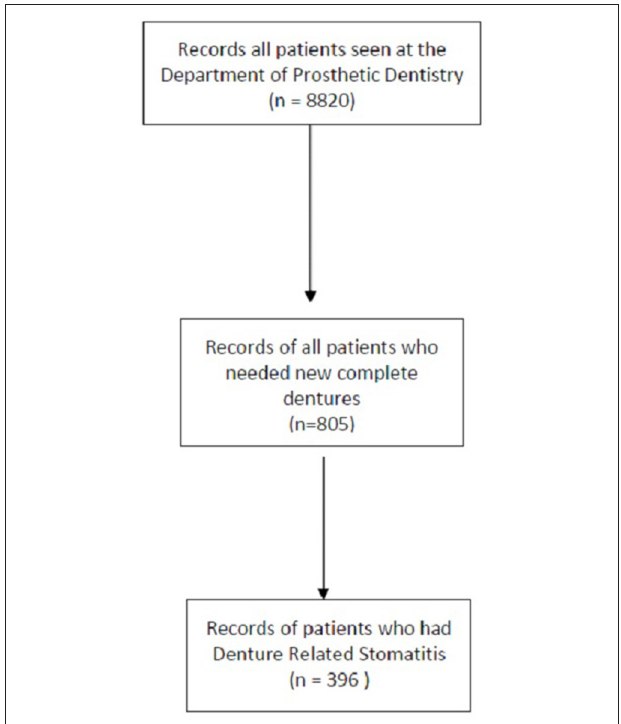
FIGURE 1 | Summary of sample